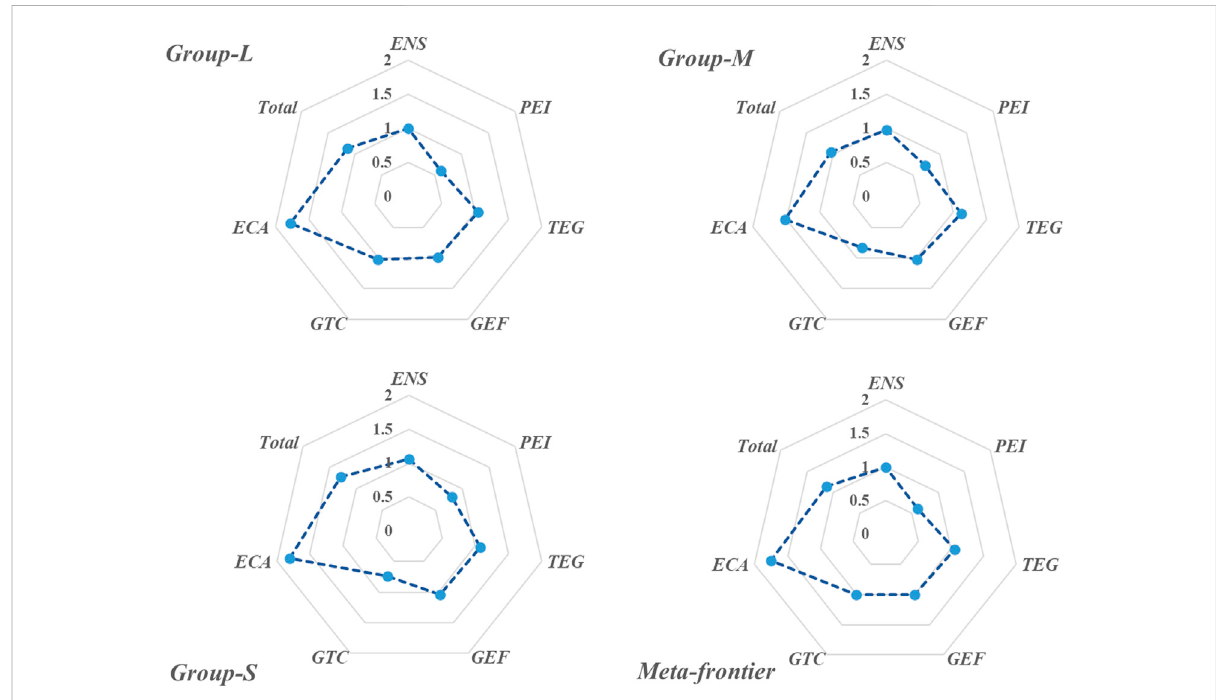
FIGURE 5 The cumulative decomposition results for sample countries ’ carbon emission change by different factors of different